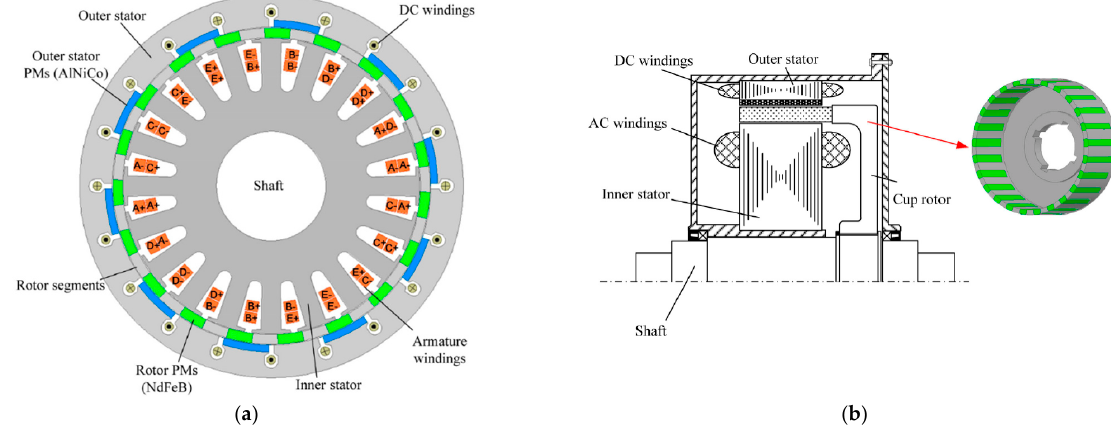
Figure 24. Five-phase bidirectional FMPM memory machine: ( a ) Cross-sectional view; ( b ) Mechanical structure [59].